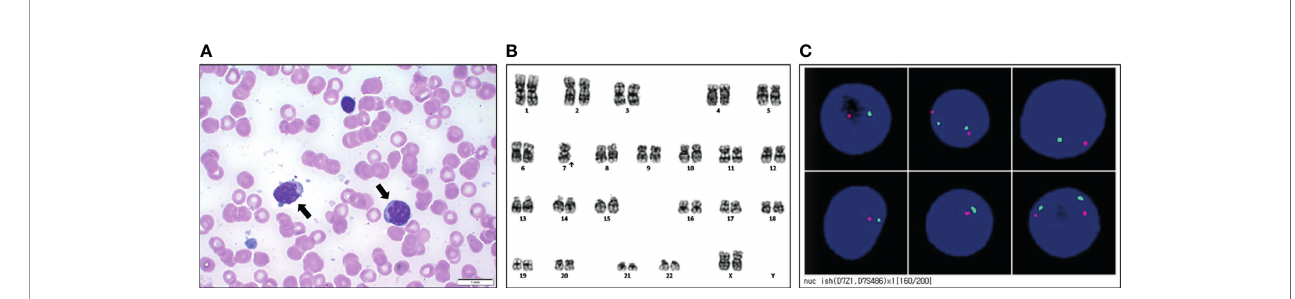
FIGURE 3 | Results of work-up at the diagnosis of acute myeloid leukemia. (A) Bone marrow smears taken from the patient (myeloblast: black arrows). (B) Representative karyotype of the blast was 45, XX, -7. (C) Fluorescence in situ hybridization of the 7q deletion showing